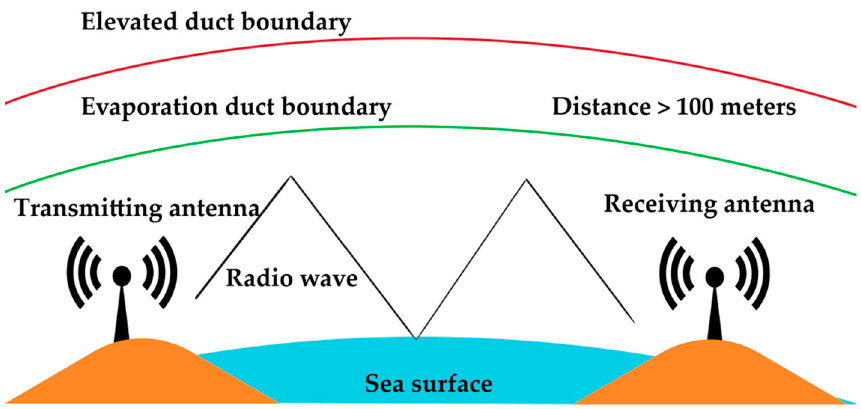
Figure 7. Transceiver platform in atmospheric ducts.